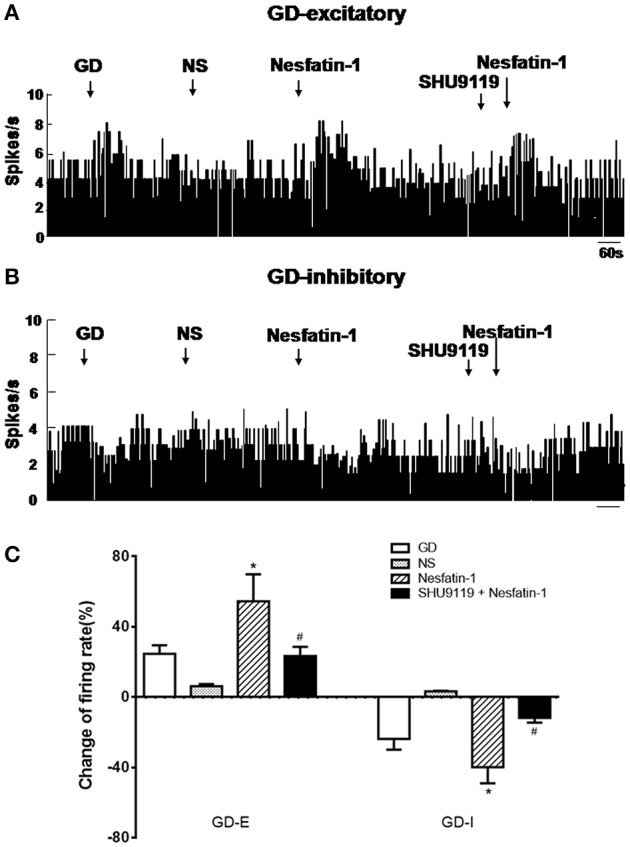
Effect of nesfatin-1 on the firing rate of GD-responsive neurons in the VMH. (A) GD-E neurons were mostly excited by nesfatin-1, (B) GD-I neurons were mostly inhibited by nesfatin-1, (C) shows the change in firing rate (%) of GD-responsive neurons in the VMH induced by nesfatin-1. Pre-treatment with melanocortin 3/4 receptors antagonist SHU9119 inhibited the effect of nesfatin-1. *P < 0.05 vs. NS; #P < 0.05 vs. nesfatin-1.